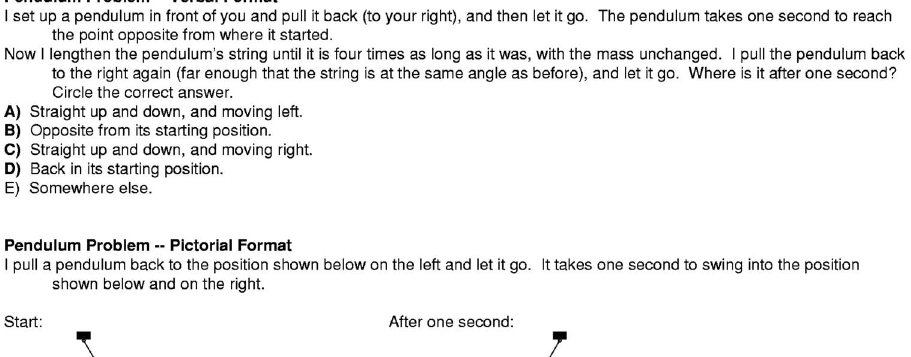
FIG. 2. Verbal and pictorial representations of the pendulum quiz given in